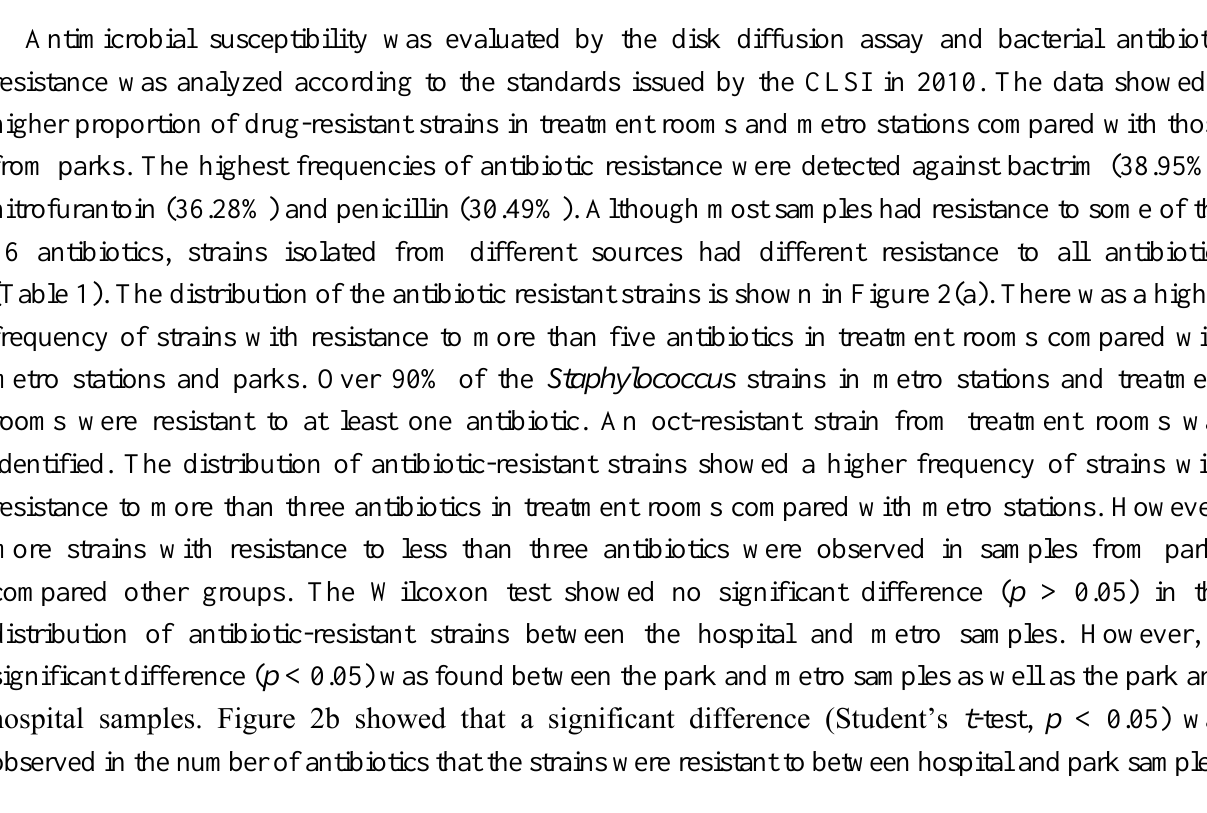
Table 1. Resistance to 16 antibiotics among bacterial samples from different